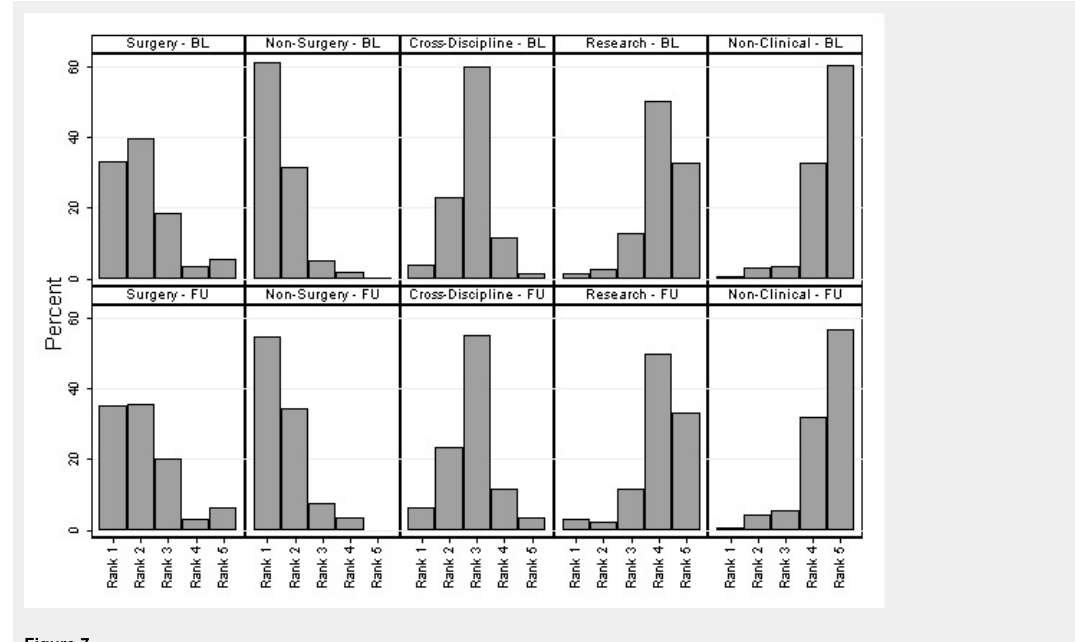
Figure 7 Please rank the following working sectors according to your preference (BL: baseline evaluation, FU: follow-up evaluation after virtual reality intervention) Surgical sector (general surgery, trauma surgery, orthopaedics, paediatric surgery, gynaecology, otorhinolaryngology, surgical ophthalmology) Nonsurgical sector (medicine, general practitioner, paediatrics, neurology, psychiatry, dermatology, emergency medicine, nonsurgical ophthalmology) Cross-disciplinary sector (anaesthesiology, radiology, pathology, legal medicine, laboratory medicine) Research sector (work in laboratory) Nonmedical sector (controlling, coding, pharmaceutical industry,